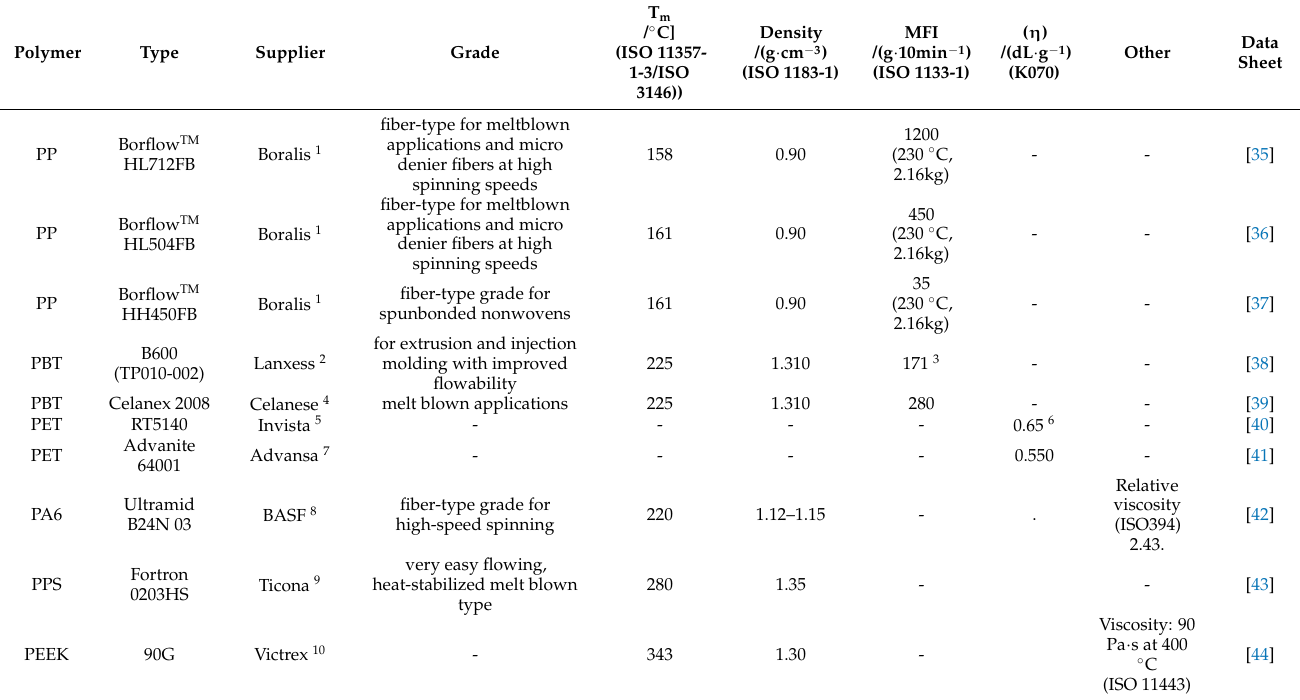
Table 2. Process-specific material properties, process set-up specifications and typical properties of meltblown and